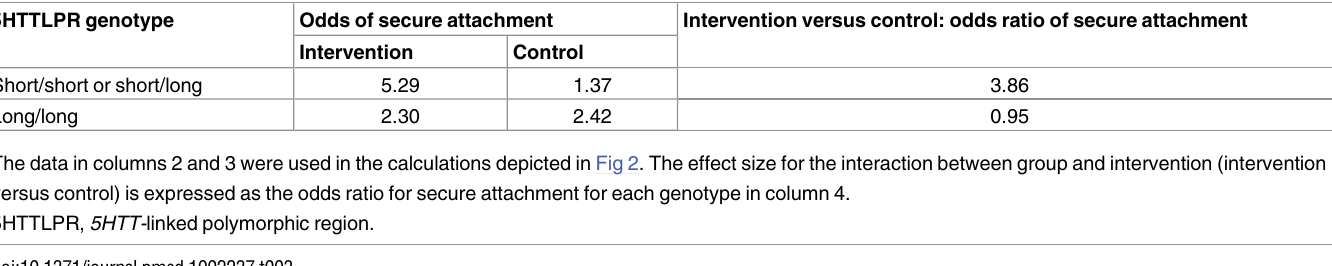
Table 3. Odds of secure attachment when the 5HTTLPR genotype × home-visiting intervention interaction is taken into account. 5HTTLPR